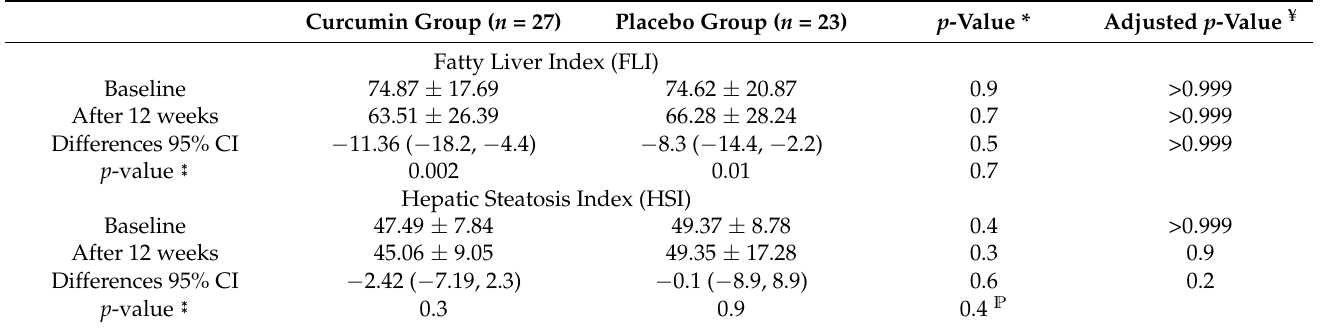
Table 1. Changes in LAP and fatty liver-associated